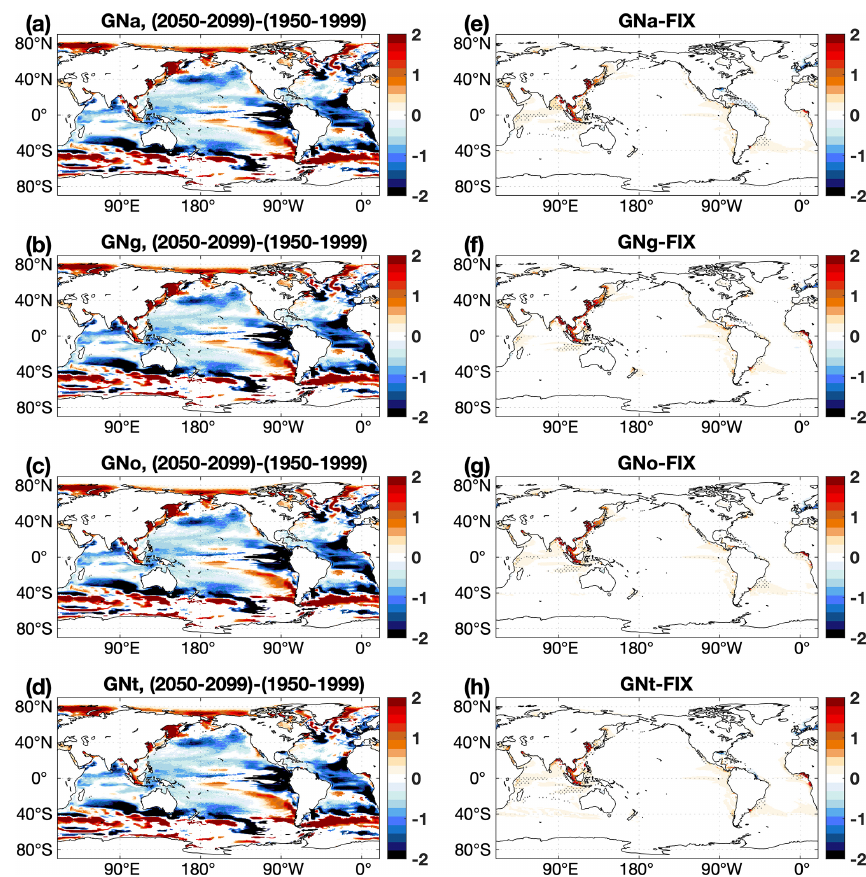
Figure 9. (a–d) Projected changes in vertically integrated primary production (molCm − 2 yr − 1 ) in four GNS experiments between the 2050– 2099 and the 1950–1999 periods. (e–h) The difference in projected changes in vertically integrated primary production (molCm − 2 yr − 1 ) between each GNS experiment and FIX. In panels (e–h) , only significant differences are plotted, and dots denote areas where the signal is larger than the standard deviation of the absolute field (see details in Appendix